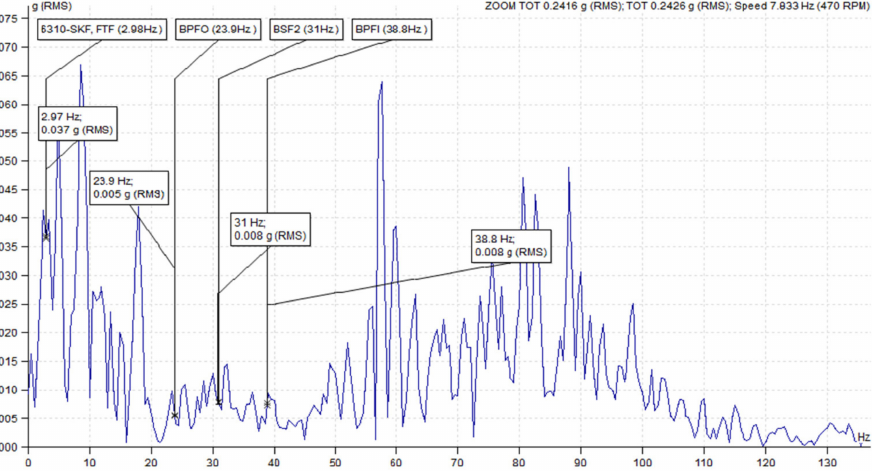
Figure 13. The fast Fourier transform (FFT) (500 Hz–16 kHz) demodulation of the 6310 SKF of the non- driving end of the threshing drum of Massey Ferguson 7370 Beta (New), a sensor mounted on a bracket.